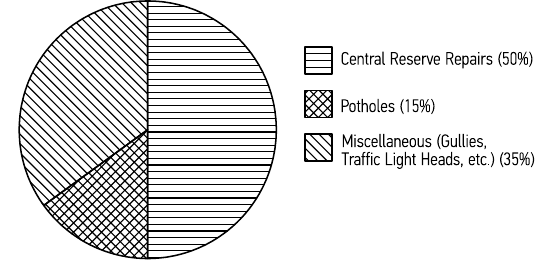
Fig. 4. Organisation chart of O&M contractor on A92 Fig. 5. A92 O&M period probability of occurrence of defects